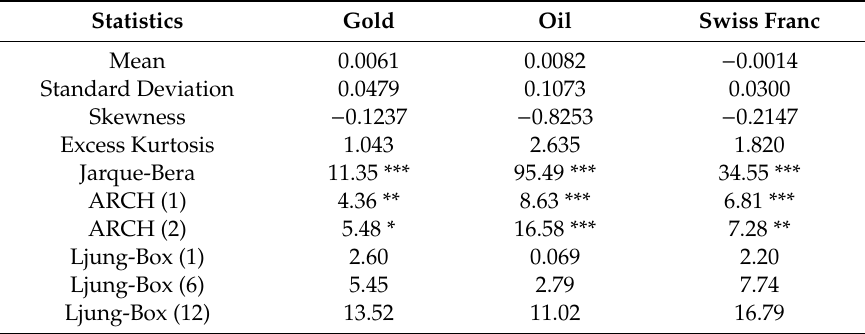
Table 1. Descriptive statistics for asset